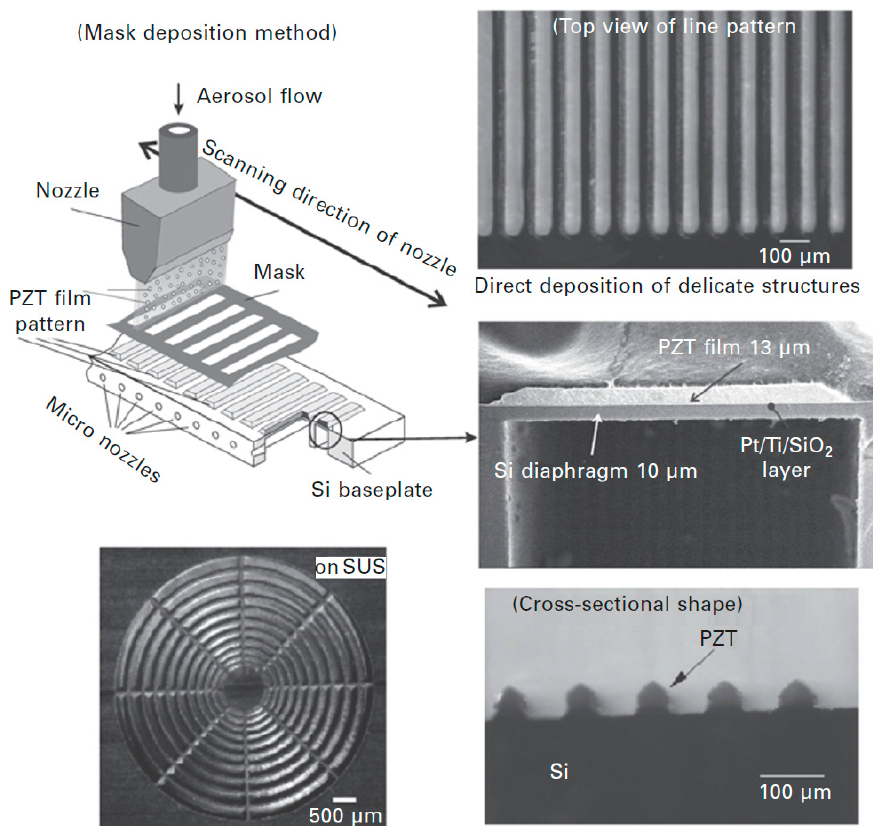
Figure 20. Patterning of thick ceramic films via AD using the mask deposition method [2]. © Copyright 2008, J. Therm. Spray Technol.